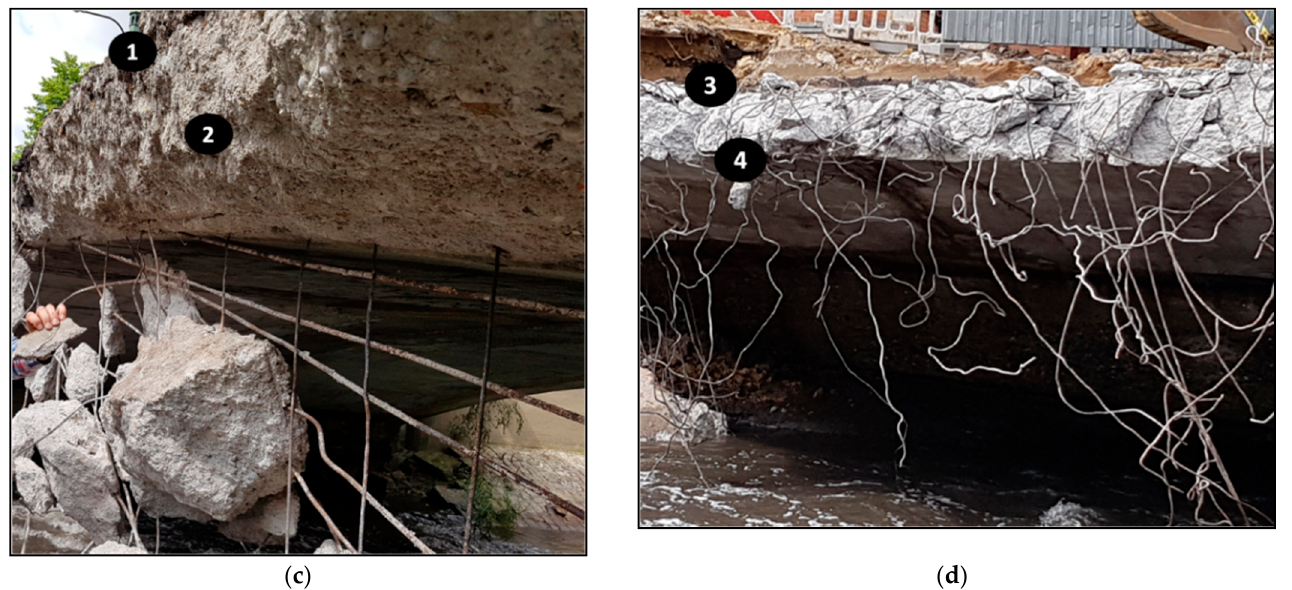
Figure 5. The sampling sites during demolition: Corroded steel mesh and carbonate icicles: ( a ) location of samples 2 and 4, ( b ) location of samples 2, ( c ) location of samples 1 and 2, ( d ) location of samples 3 and 4.